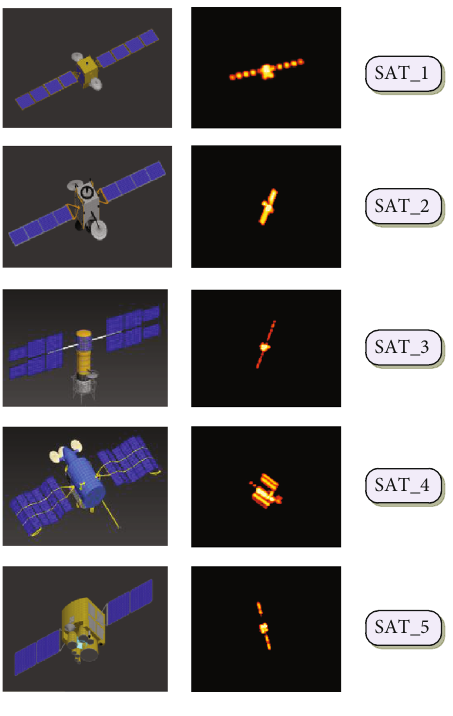
Figure 14: 3D mesh models and ISAR imaging results of 5 types of space targets.